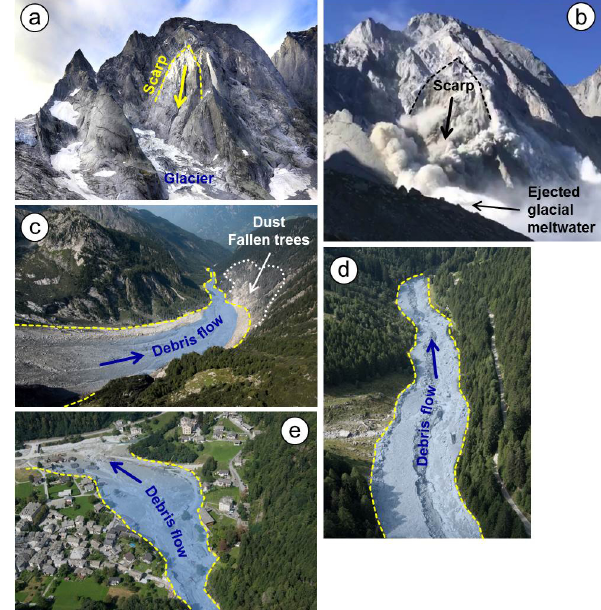
Figure 3. The 2017 Piz Cengalo–Bondo landslide cascade. (a) Scarp area on 20 September 2014. (b) Scarp area on 23 Septem- ber 2017 at 09:30LT, 20s after release, in frame of a video taken from the Capanna di Sciora. Note the fountain of water and/or crushed ice at the front of the avalanche, most likely represent- ing meltwater from the impacted glacier. (c) Upper part of Val Bondasca, where the channelized debris flow developed. Note the zone of dust- and pressure-induced damage to trees on the right side of the valley. (d) Traces of the debris flows in Val Bon- dasca. (e) The debris cone of Bondo after the event. Image sources: © Daniele Porro (a) , © Diego Salasc/Reto and Barbara Salis (b) , and © swisstopo (c–e)